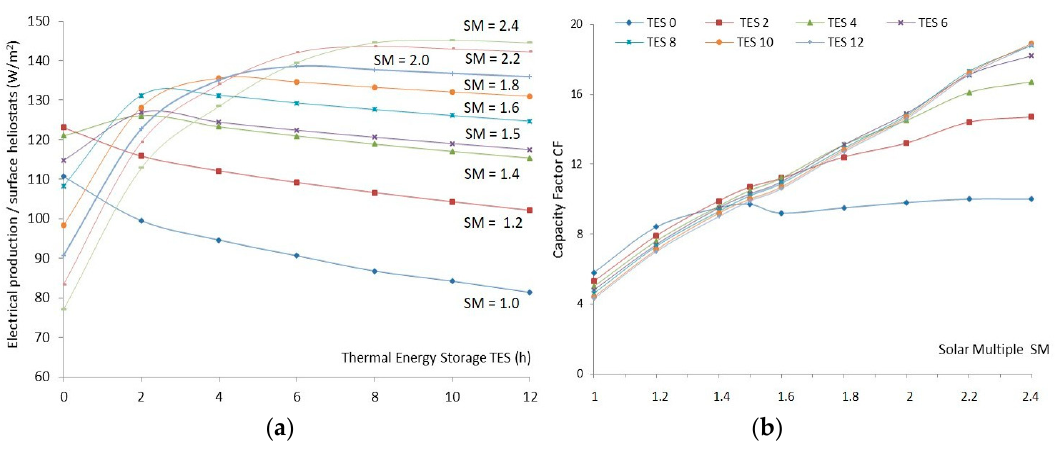
Figure 8. ( a ) Effect of Thermal Energy Storage ( TES) on electrical production/m 2 (surface heliostats) under different values of solar multiple (Djelfa). ( b ) The solar multiple effect on capacity factor ( CF ) under different TES values (Djelfa).